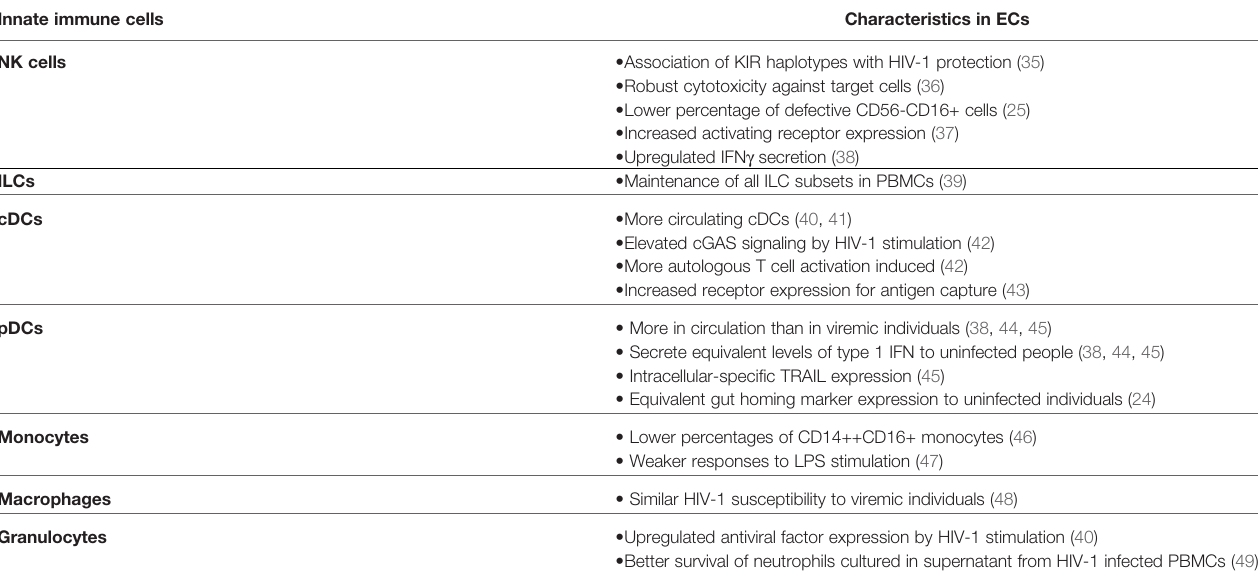
TABLE 1 | Characteristics of HIV-1 elite controller innate immune cells. Innate immune cells Characteristics in